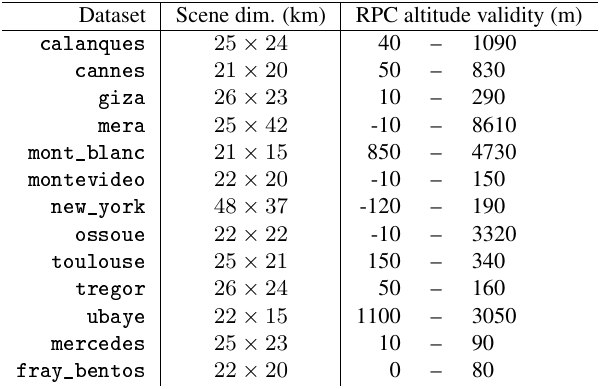
Table 2: Pléiades datasets used for the